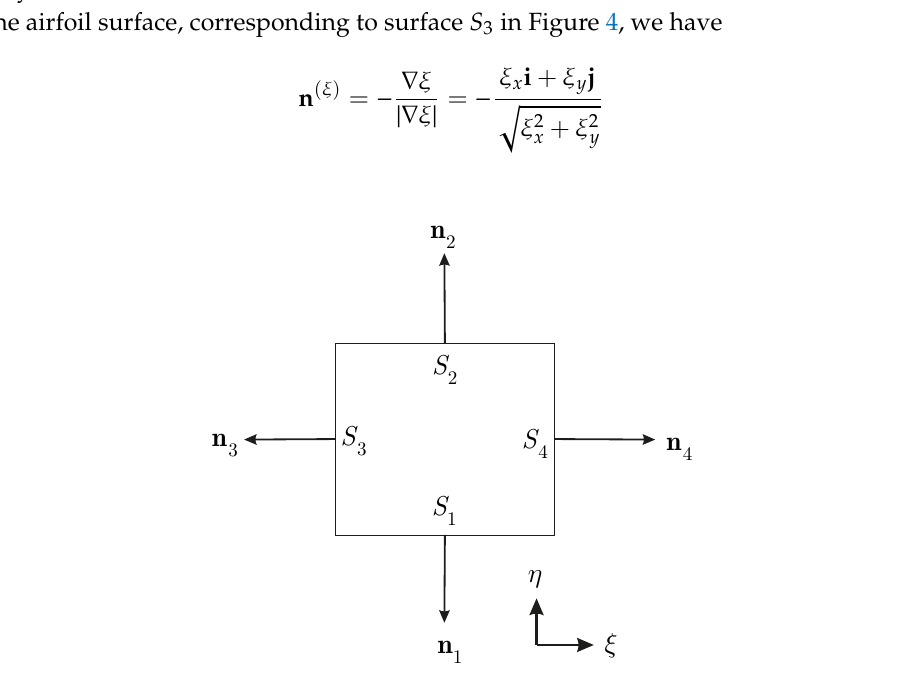
Figure 4. The outward—pointing unit normal vectors to ξ =constant and η =constant lines.